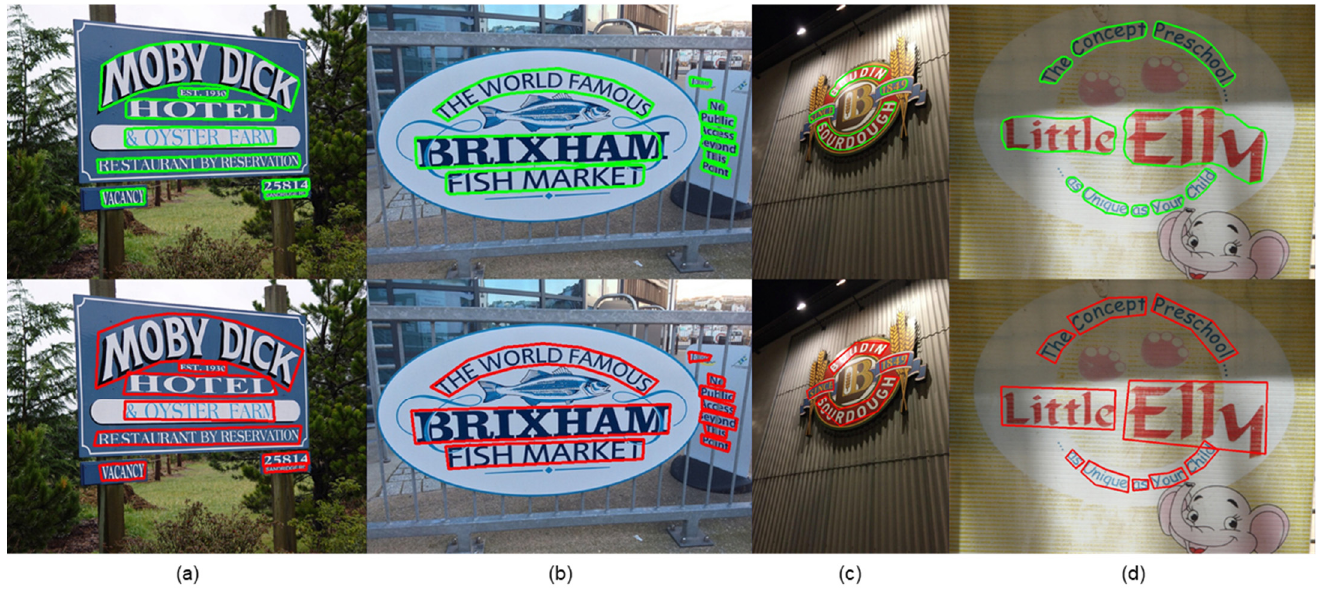
Figure 7. Visualization results ( a , b ) show that our method works better in the lower half compared to other methods in the upper half in detecting text and art words with different viewpoints. ( c , d ) further show the detection of text ignored during text annotation, where the upper half is the detection effect of our model and the lower half is the text annotation ground truth.